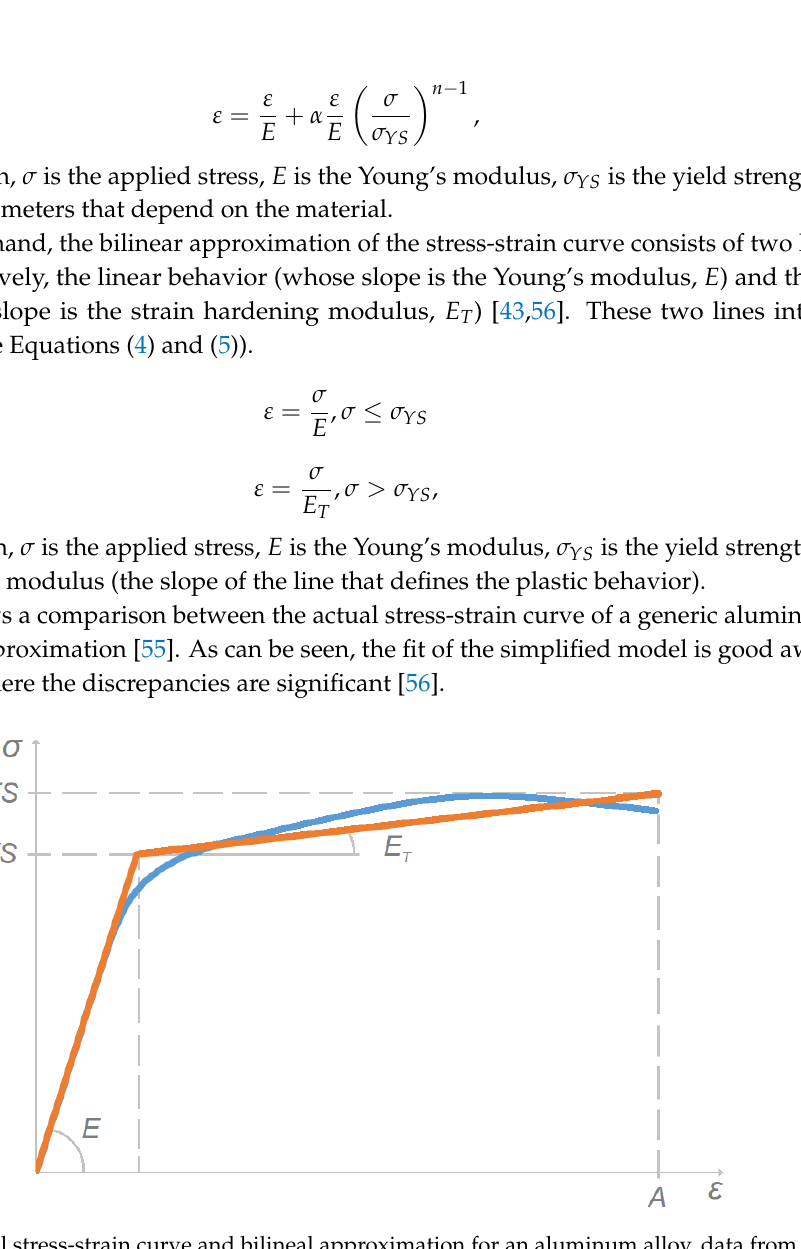
Figure 2. Actual stress-strain curve and bilineal approximation for an aluminum alloy, data from [55]. The shape of the stress-strain curve (real and approximate) and its values depend on